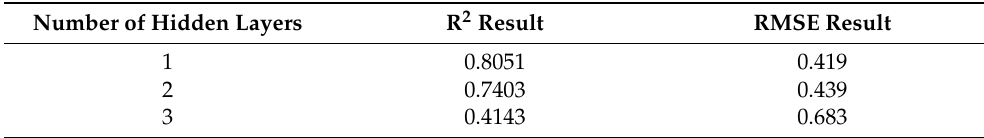
Table 6. Analysis results under different numbers of hidden layers using BP neural network with the F 60 as the output node.